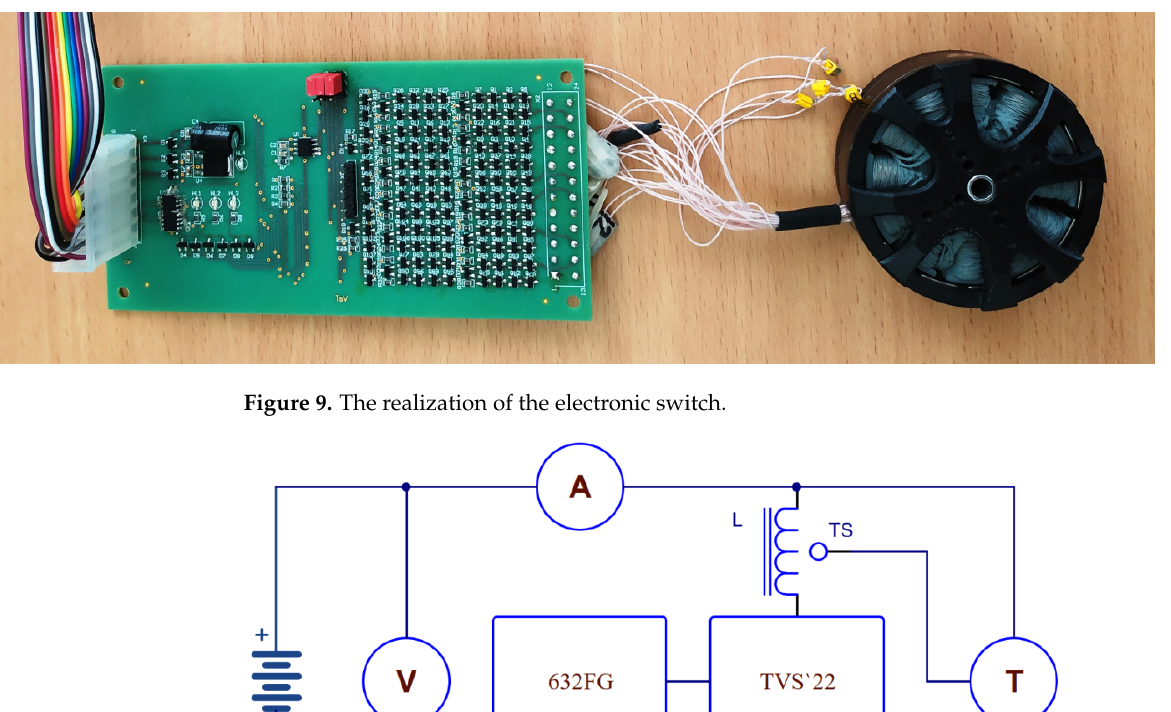
Figure 10. The experimental set-up .